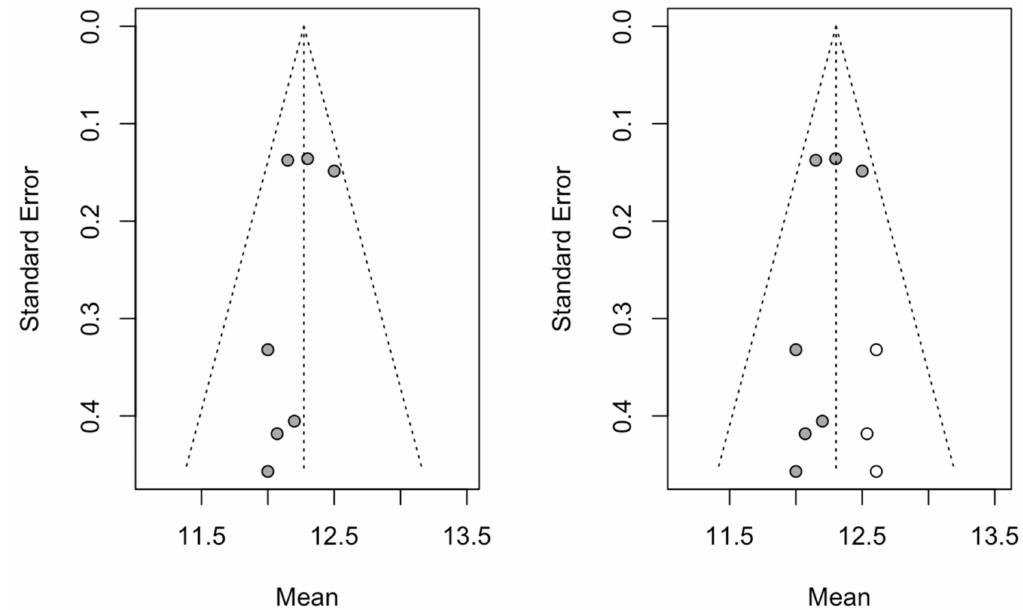
Figure 10. Initial funnel plot and plot after trim and fill adjustment of the mean difference in PES for the immediate dental implant placement using the socket-shield technique in the esthetic